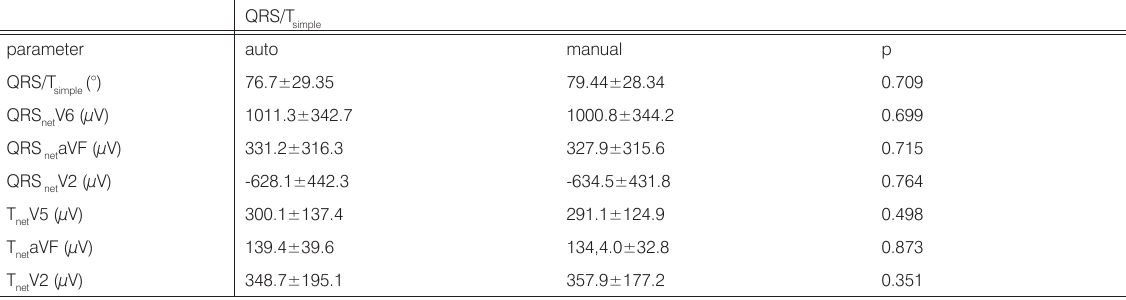
as well as measured amplitudes (components used for calculation of QRS/T) by automatic and manual measure- simple